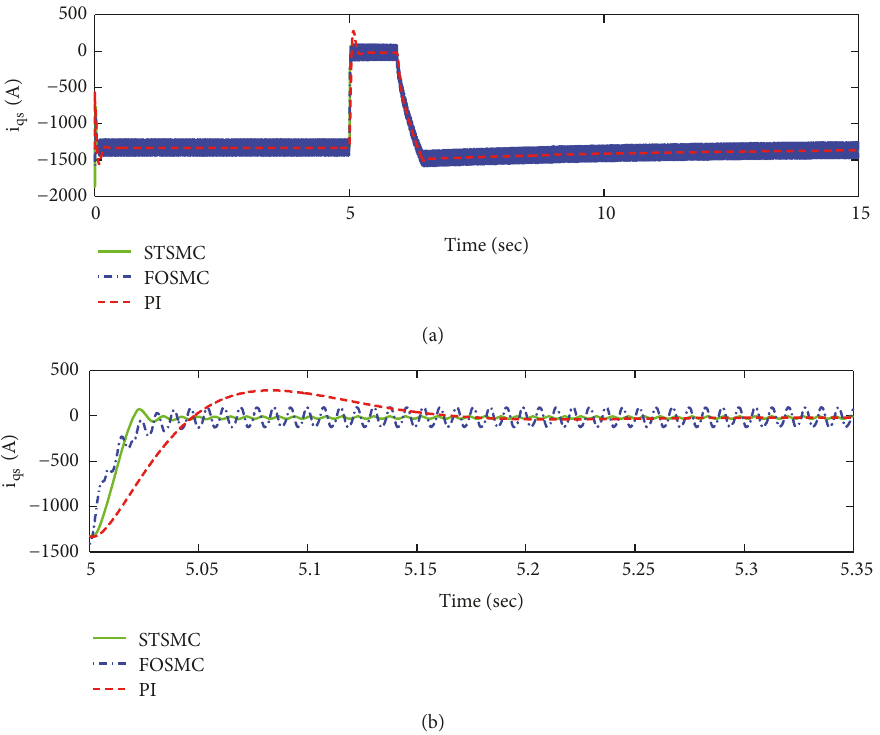
Figure 6: The q-axis current of the generator (a) with PI, FOSMC, and STSMC in the grid fault condition, (b) in beginning time of grid voltage drop.